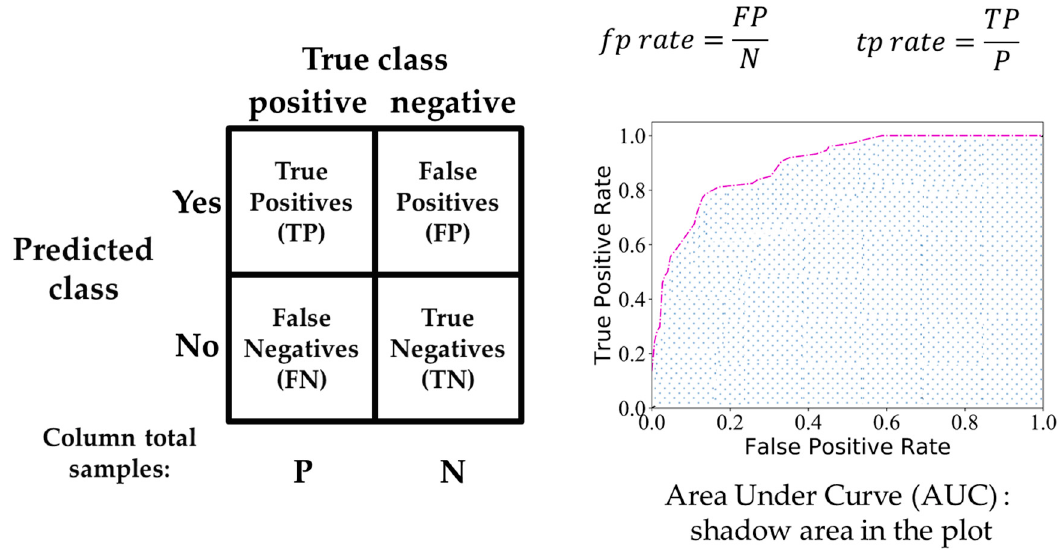
Figure 3. Confusion matrix ( left ) and a sketch of ROC curves ( right ) .